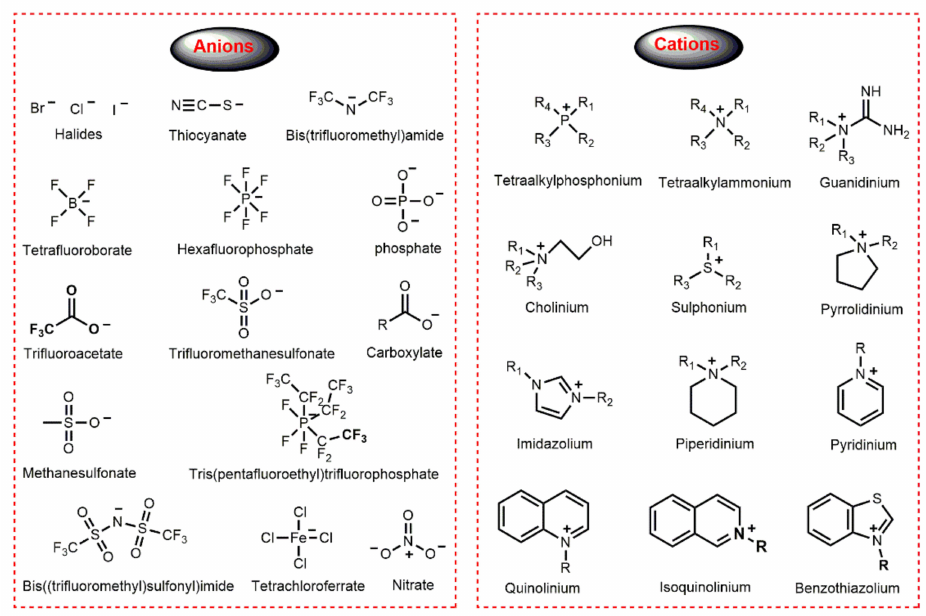
Figure 1. Structure of some common anions and cations of